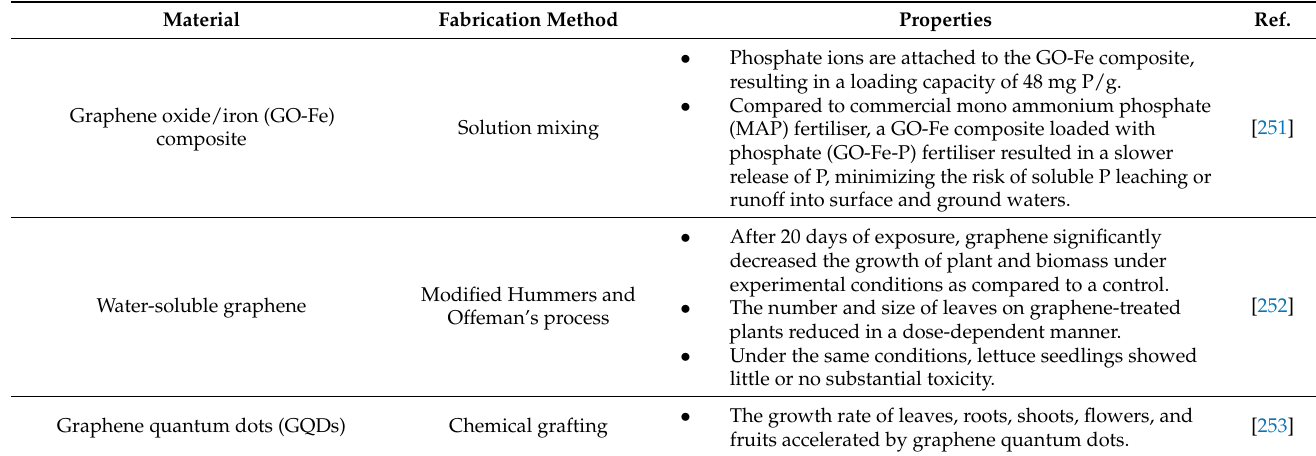
Table 5. Fabrication and properties of the graphene-based materials used in agriculture and wastewater